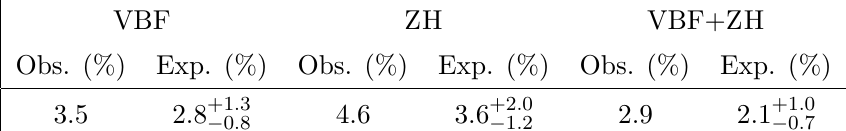
Table 5 . Observed and expected 95% CL limits at m VBF category, ZH category, and their